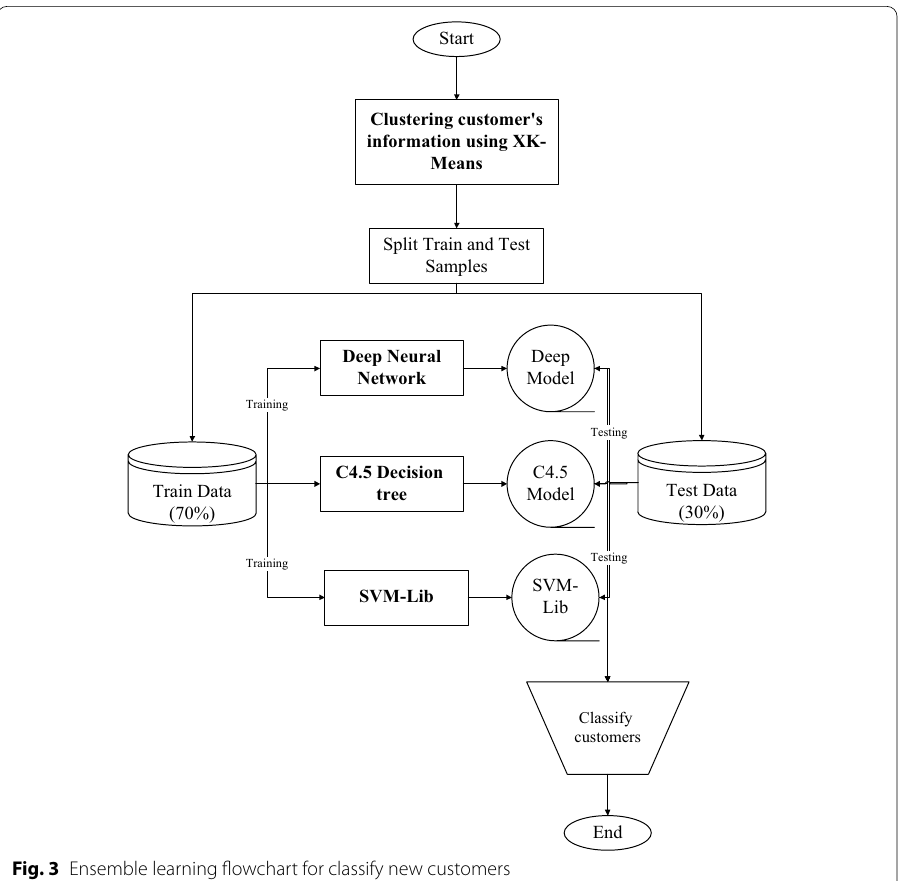
Fig. 3 Ensemble learning flowchart for classify new